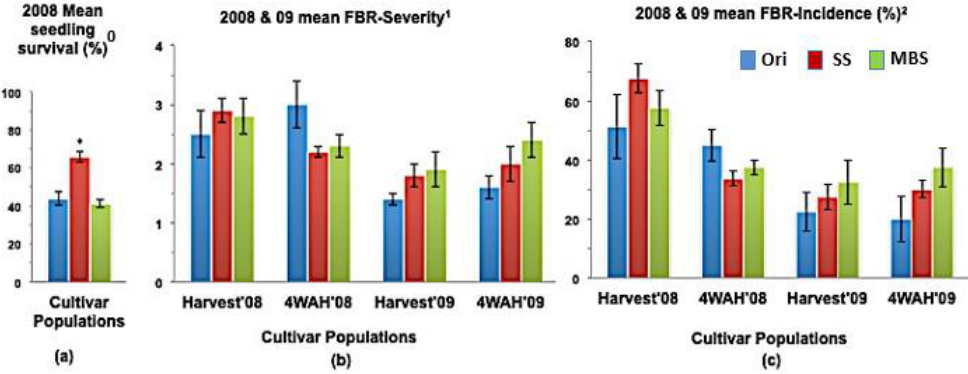
Figure 2. ( a ) Mean seedling survival, ( b ) Mean bulb FBR severity, and ( c ) Mean bulb FBR incidence (%) of NuMex Camino Ori, SS, and MBS populations in 2008 and 2009 evaluations. Std. error is shown on top of each bar. Grouping legend is provided in ( c ). (*) Significantly different from original at P = 0.05. 0 75 seeds of each population were sown in each tray for seedling evaluation. 1 Disease severity of 20 arbitrarily selected bulbs was rated at harvest (Harvest ’08 and ’09) and again four weeks after harvest (4WAH ’08 and ’09) on an scale of 1 to 9 [32]. 2 Percentage of susceptible individuals out of the total number of individuals of 20 arbitrarily selected bulbs was observed at harvest (Harvest ’08 and ’09) and again four weeks after harvest (4WAH ’08 and ’09).